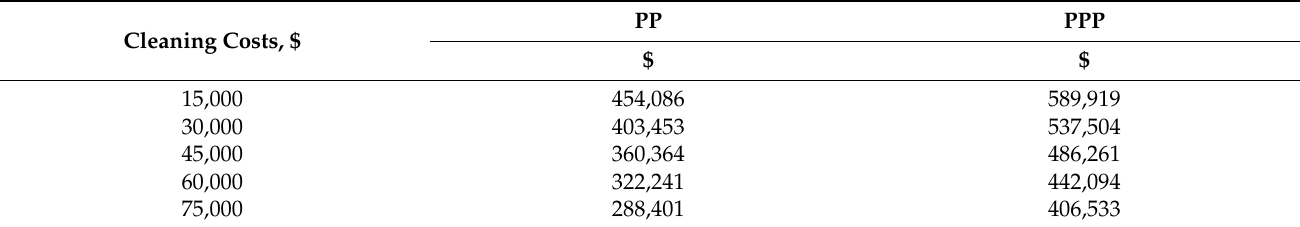
Table 8. The possible economic value which can be obtained using the proposed